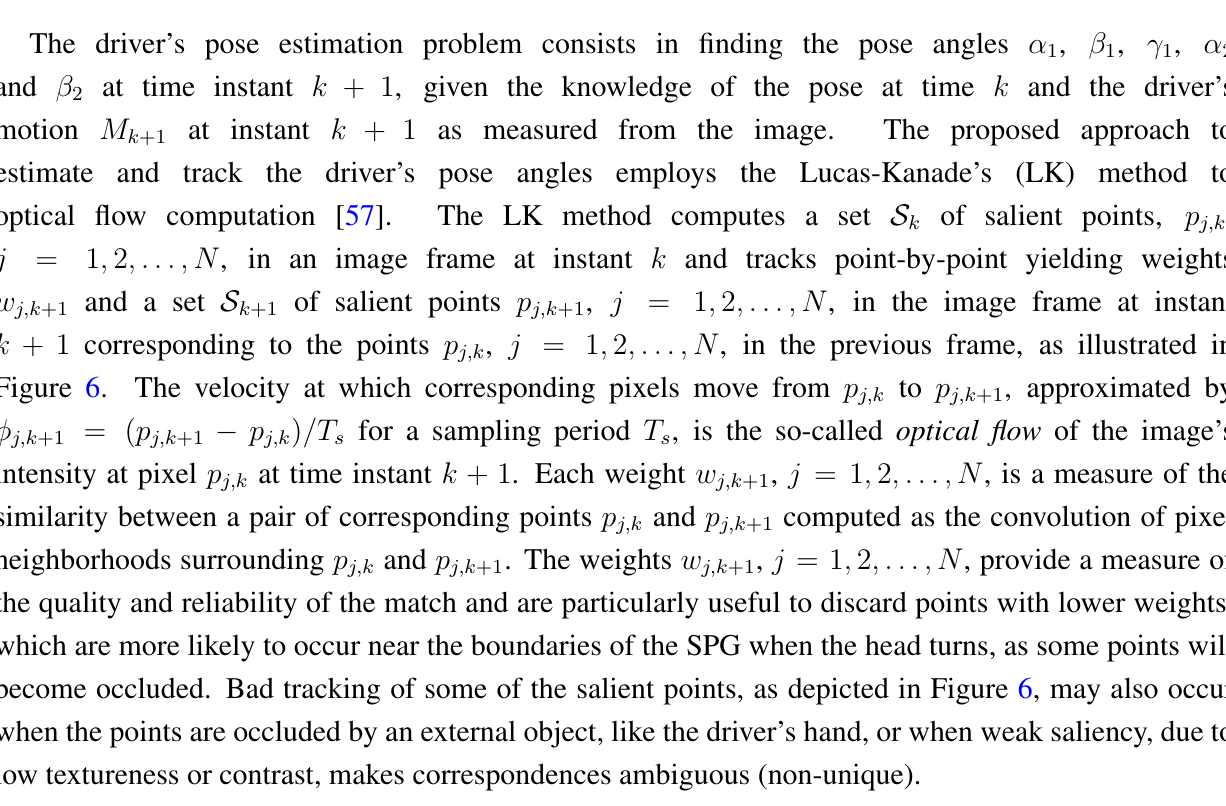
Figure 6. Example of LK tracking between two frames, showing an incorrectly tracked